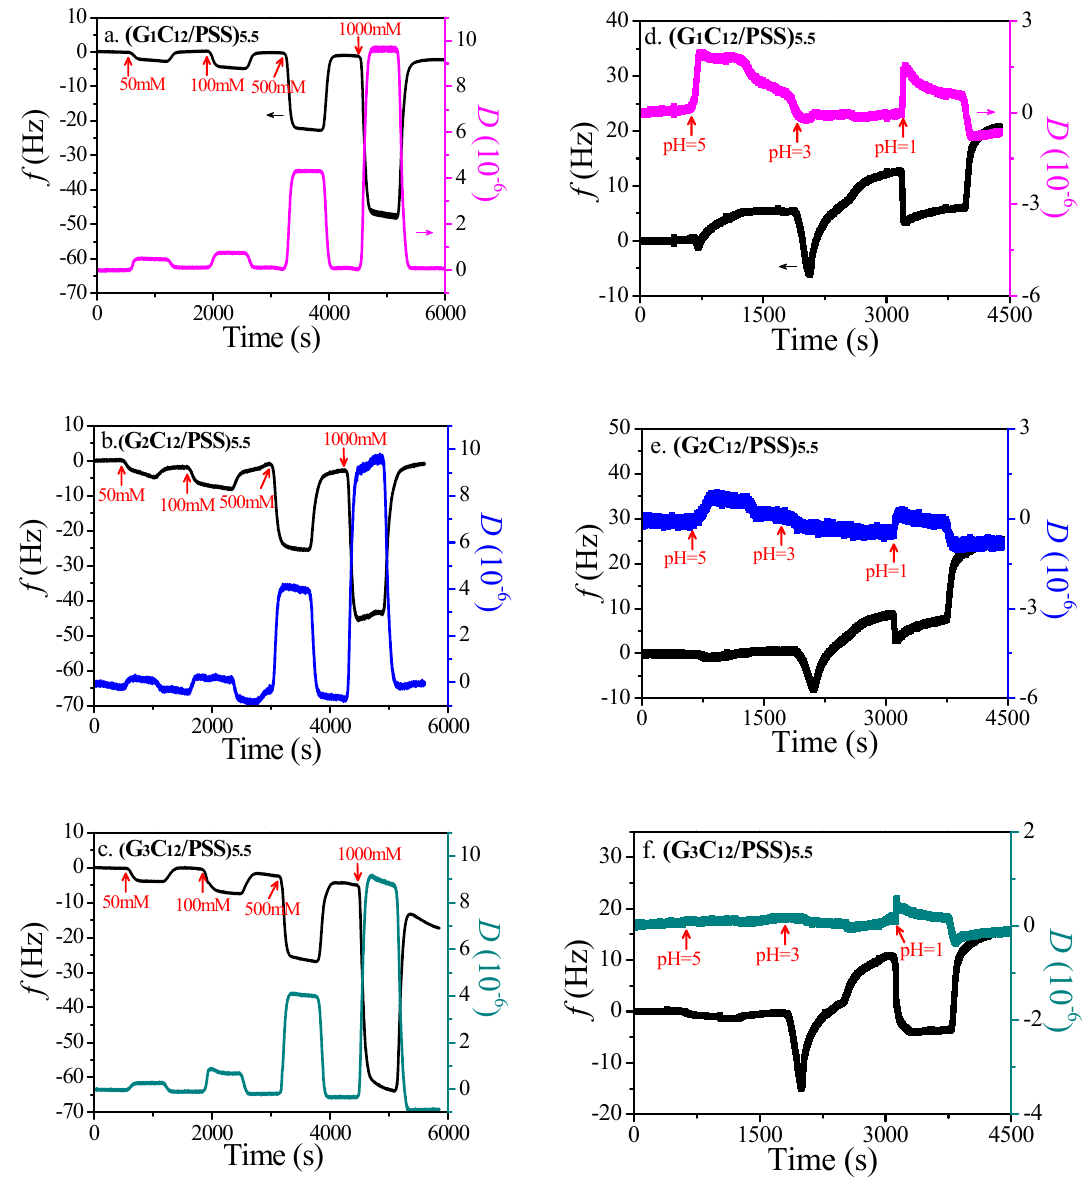
Figure 3. Shifts of frequency and dissipation in response to salt for multilayer assemblies of ( a ) (G 1 C 12 /PSS) 5.5 , ( b ) (G 2 C 12 /PSS) 5.5 , and ( c ) (G 3 C 12 /PSS) 5.5 ; and in response to pH for multilayer assemblies